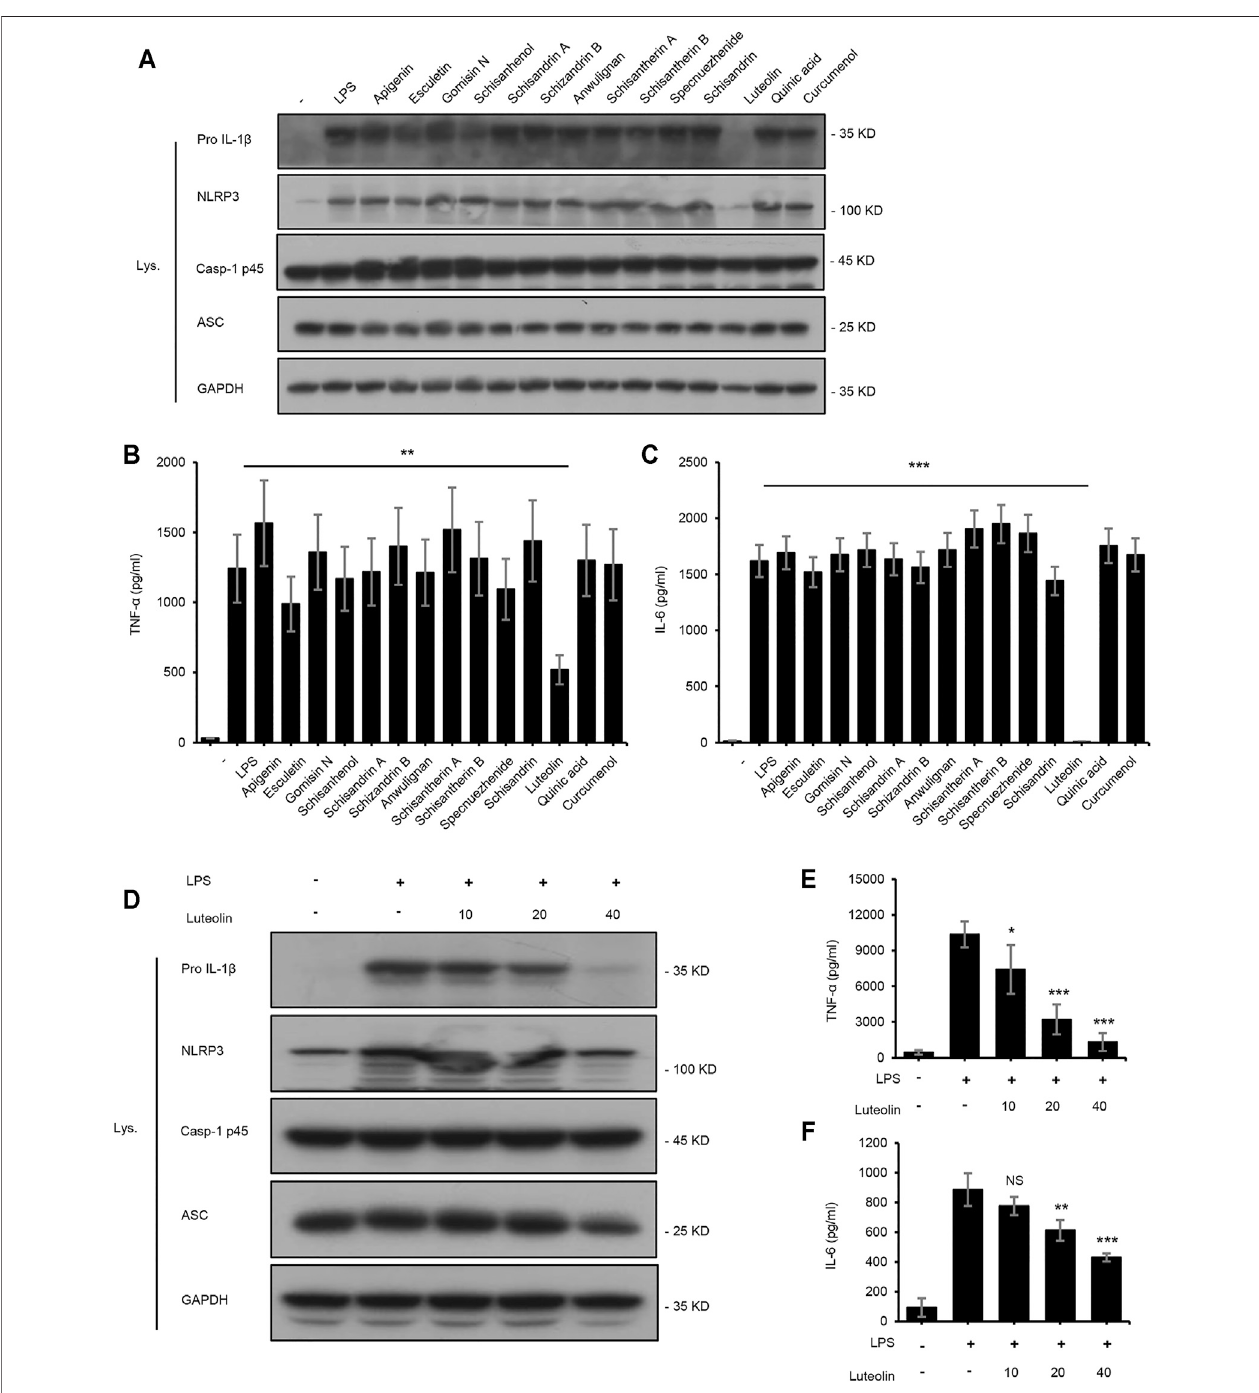
FIGURE 4 | Luteolin inhibits the NF- κ B signaling pathway. (A) Western blotting of pro IL-1 β , NLRP3, Casp-1 p45, ASC, and GAPDH in BMDMs treated with apigenin, esculetin, gomisin N, schisanhenol, schisandrin A, schisandrin B, anwulignan, schisantherin A, schisandrin B, specnuezhenide, schisandrin, luteolin, quinic acid, and curcumenol (40 μ M) for 4 h and then stimulated with LPS (50 ng/ml) for 1 h. (B,C) ELISA of TNF- α (B) and IL-6 (C) in SN from samples described in A. (D) Westernblotting ofproIL-1 β , NLRP3, Casp-1 p45, ASC,and GAPDHin BMDMs treatedwith luteolin for 4 hand then stimulated withLPS (50 ng/ml) for1 h. (E,F) ELISAofTNF- α (E) andIL-6 (F) inSNfromsamplesdescribedinD.GAPDHservedasaloadingcontrol.Dataarerepresentedasthemean ± SDusingbiologicalsamples.